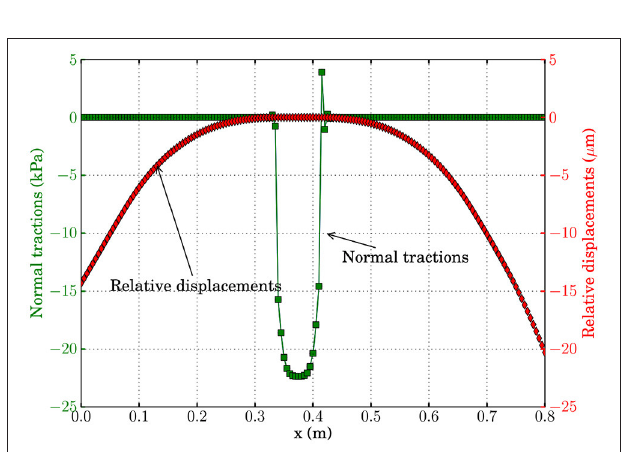
FIGURE 11 | Normal tractions and the relative normal displacements computed along the potential contact zone by the algorithm EC-BEM, for both domains (cid:127) 1 and (cid:127) 2 .